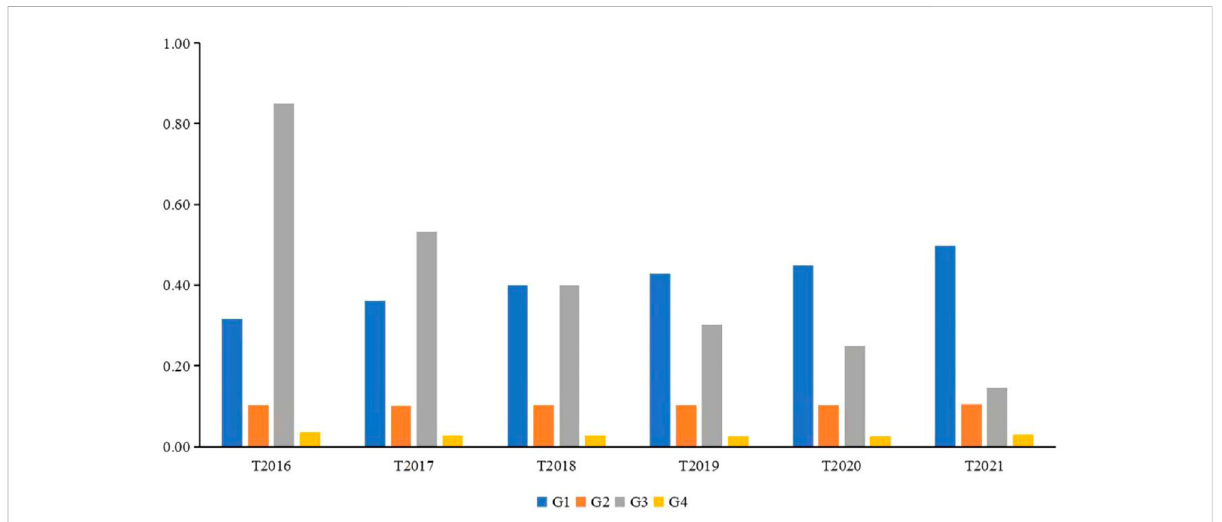
FIGURE 1 Spatial Gini coef fi cient of new energy industry. G1, science and technology promotion G2, scienti fi c research G3, experimental development G4, specialist technical services.